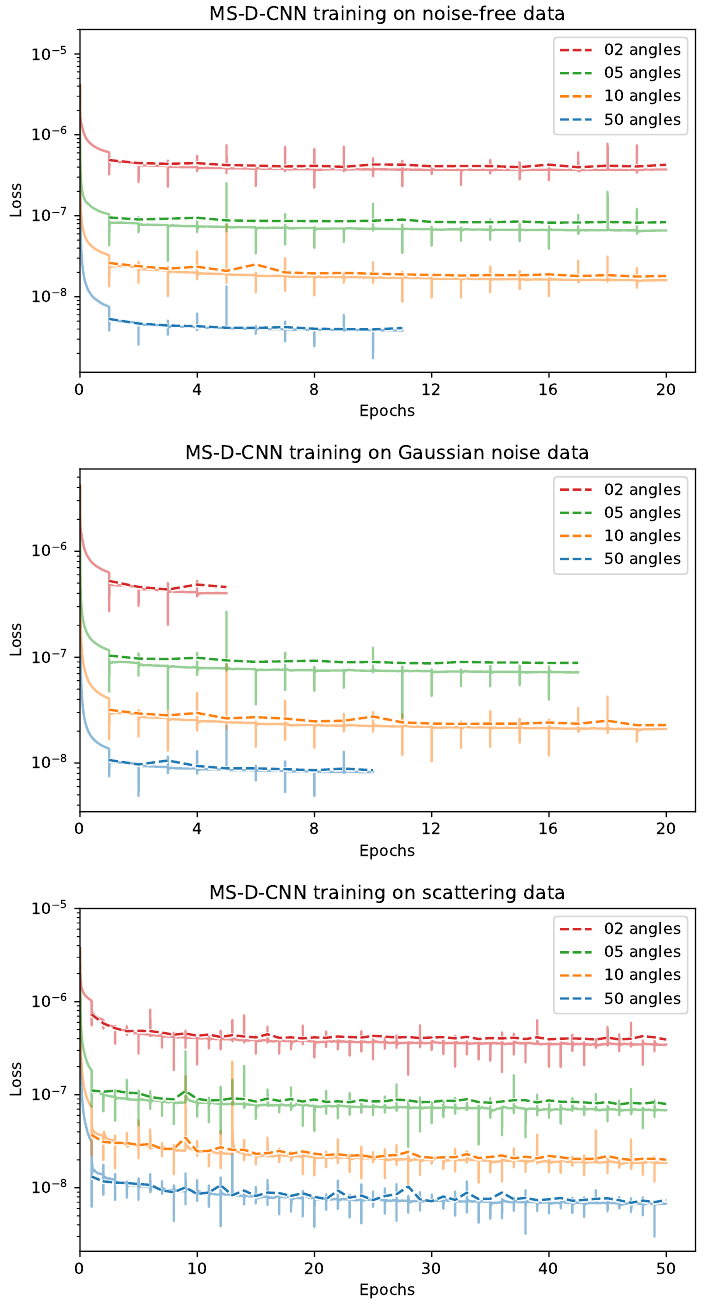
Figure A13. Training curves of MS-D-CNN on the Apple CT dataset. Dashed lines: average validation loss computed after every full training epoch; solid lines: running average of training loss since start of epoch. Duration of 20 epochs on full dataset: ≈ 20